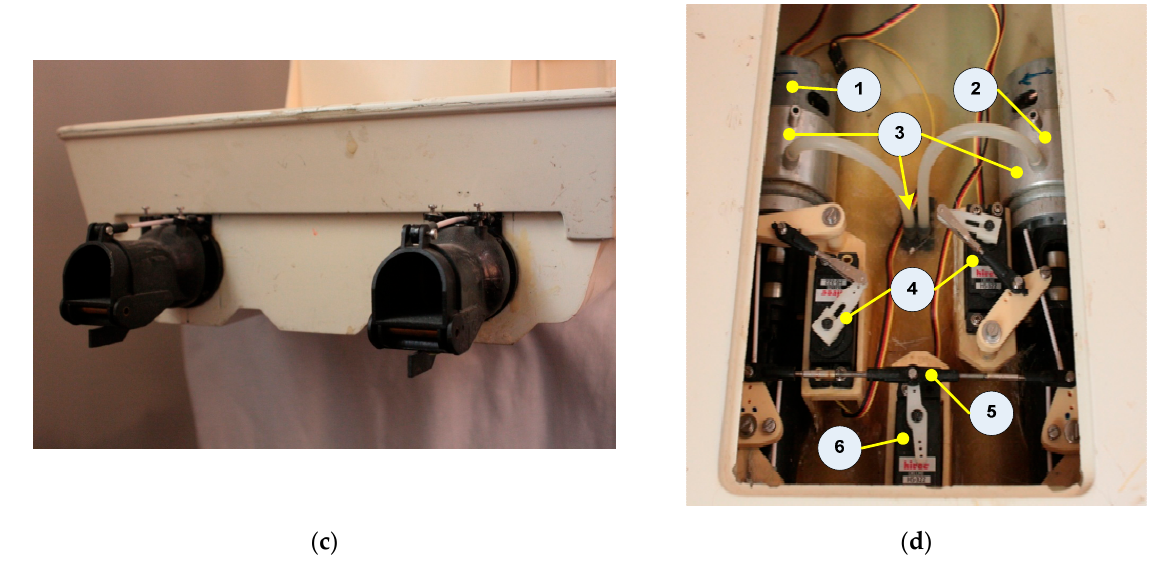
Figure 3 . Development platform. ( a ) Initial phase of construction; ( b ) Vessel ready for measurements; ( c ) Waterjet nozzles; ( d ) Propulsion motors and control servos.